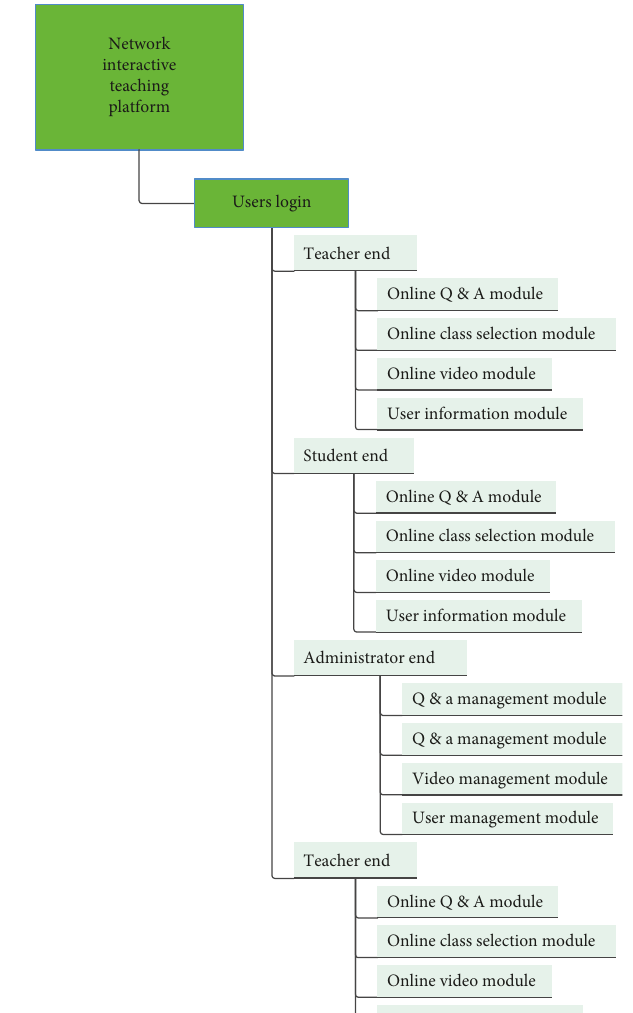
Figure 4: The functional structure diagram of the